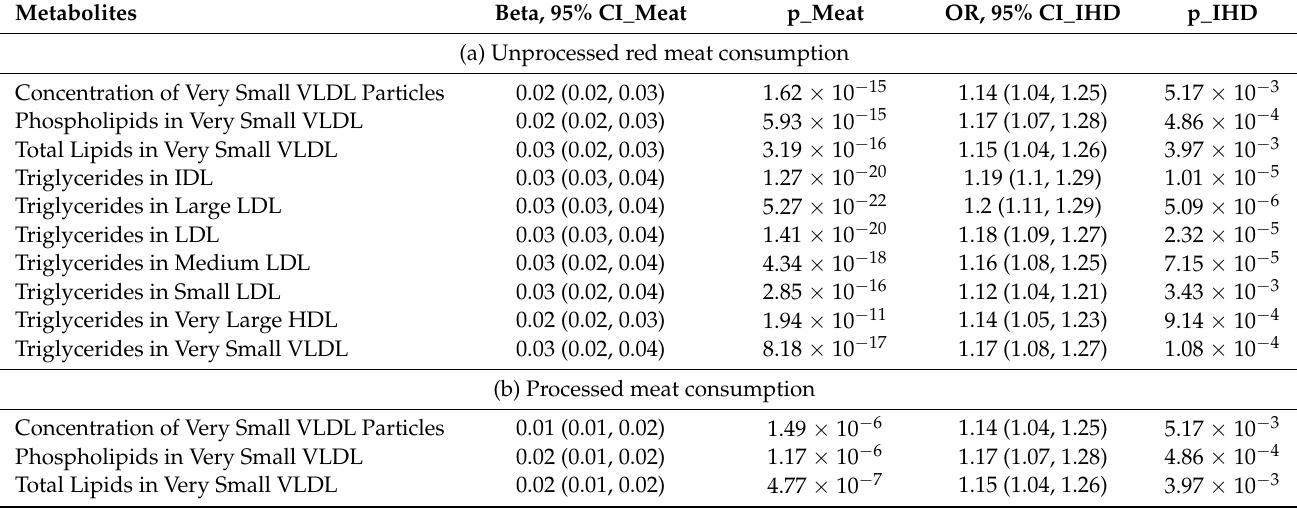
Table 3. Association of 10 metabolic biomarkers with red meat and with ischemic heart disease in